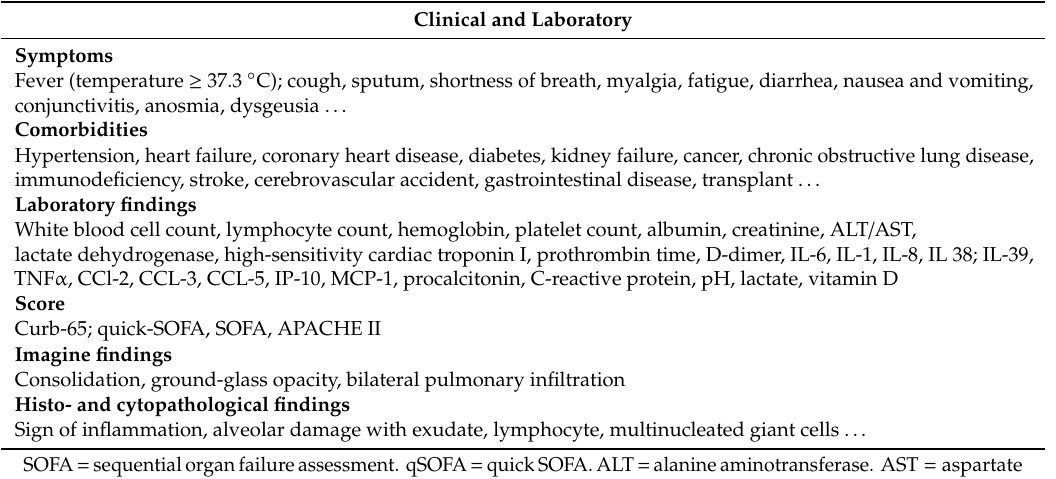
Table 3. Clinical, laboratory, and imaging findings commonly found in patients with SARS-CoV-2